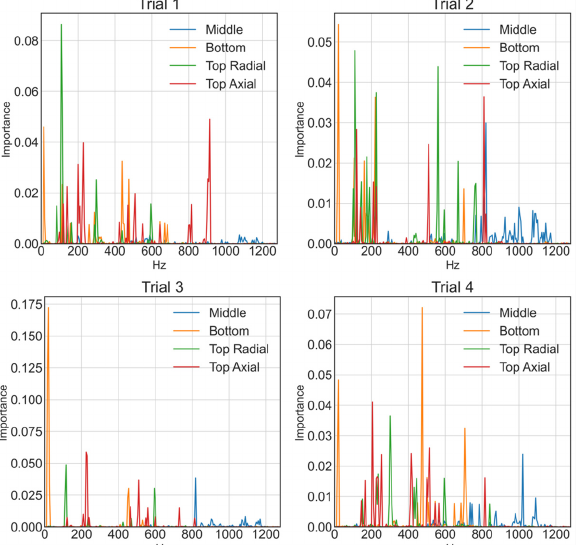
Figure 10. 4-Fold cross-validation for trials 1 to 4 of Gini importance considering 20 times averages using ERTs with optimal Linearity setting (n_estimators = 100, max_depth = None, min_samples_leaf = 2, min_samples_split = 10), and T RUL = 70 days.